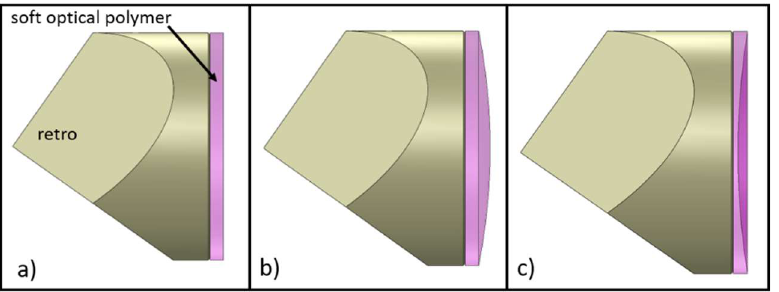
Figure 1. Schematic of an adaptive retroreflector using a solid elastomeric polymer: ( a ) flat ( b ) convex and ( c ) concave.